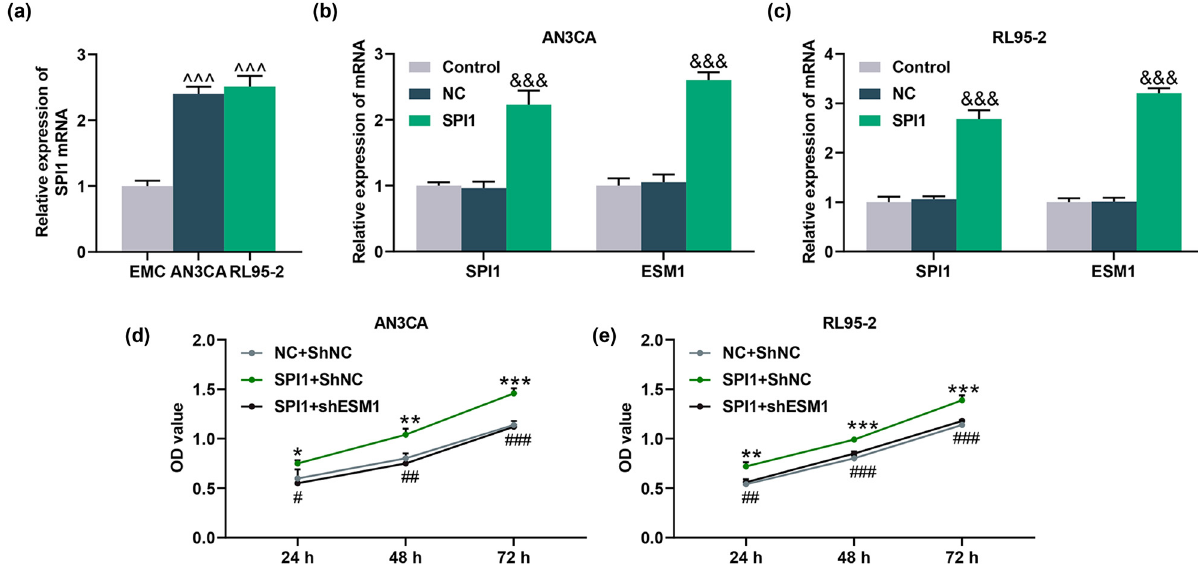
Figure 7: SPI1 overexpression promoted ESM1 level and viability of EC cells, and silencing of ESM1 reversed the e ff ect of SPI1 overexpression on the viability of EC cells. ( a ) The expression of SPI1 in EMCs as well as AN3CA and RL95 - 2 cells was detected by qRT - PCR, and SPI1 was highly expressed in AN3CA and RL95 - 2 cells. ( b and c ) After AN3CA and RL95 - 2 cells were transfected with SPI1 overexpression plasmid, the expression levels of SPI1 and ESM1 were quanti fi ed by qRT - PCR. ( d and e ) Twenty - four, forty - eight, or seventy - two hours after cell transfection with SPI1 overexpression plasmid and shESM1, the e ff ects of overexpressed SPI1 and silent ESM1 on the viability of AN3CA and RL95 - 2 cells were evaluated by MTT assay. ^^^ P < 0.001 vs EMC; &&& P < 0.001 vs NC; * P < 0.05, ** P < 0.01, *** P < 0.001 vs NC + ShNC; # P < 0.05, ## P < 0.01, ### P < 0.001 vs SPI1 +